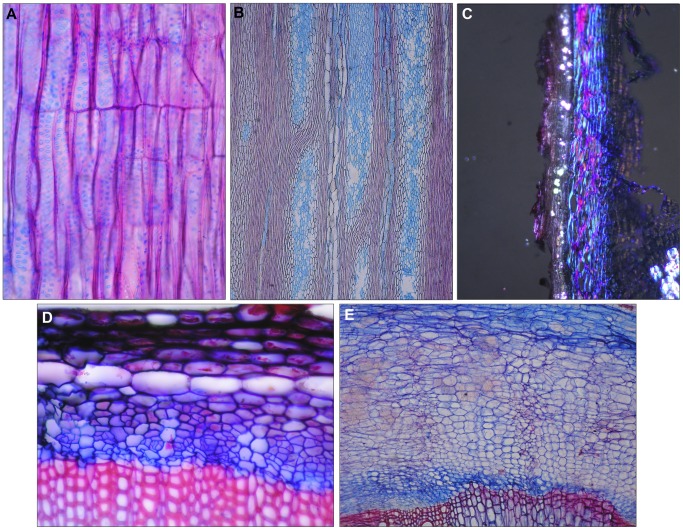
(A) Radial section of a uniseriate ray with upright cells. Root collar of a Campanula drabifolia, 5 cm tall perennial herb in a dry meadow of the Mediterranean zone, Crete, Greece. (B) Tangential section of very large rays, partially confluent with the axial tissue. Root collar of Gadellia lactiflora, 80 cm tall perennial herb, meadow, subalpine zone of the Georgian Caucasus. (C) Crystal sand in the phellem. Root collar of Campanula giesekiana, 5 cm tall perennial herb, on rock, arctic zone, Greenland. Polarized light. (D) Phloem with small groups of sieve tubes and companion cells. Root collar of Campanula rapunculoides, 40 cm tall perennial herb, meadow, hill zone of Switzerland. (E) Phloem with small groups of sieve tubes and companion cells between large parenchyma zones. Root collar of Petromaerula pinnata, 80 cm tall perennial herb, meadow, Mediterranean zone, Crete, Greece.